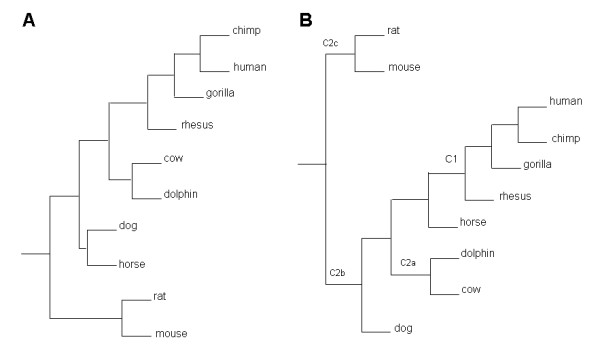
Phylogeny of HOTAIR. (A) A tree built with concatenated sequences of orthologues of exon1, exon3, exon4 and exon5. (B) A tree built with sequences of exon6 orthologues. C1 indicates the first local clock, while C2a, C2b and C2c indicate the second local clock inserted at three different places in different computations.